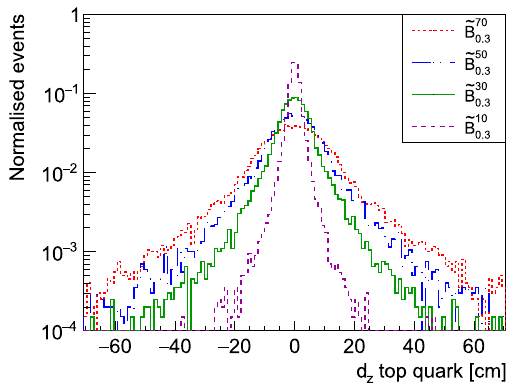
Fig. 19 Missing transverse hadronic energy MHT in the ˜ B -like case